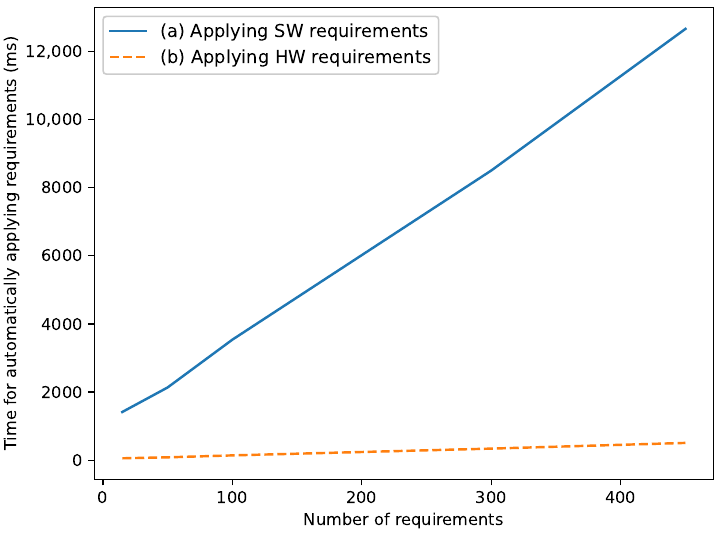
Figure 14. Runtime for parsing safety requirements and applying the corresponding model represen- tation of the safety